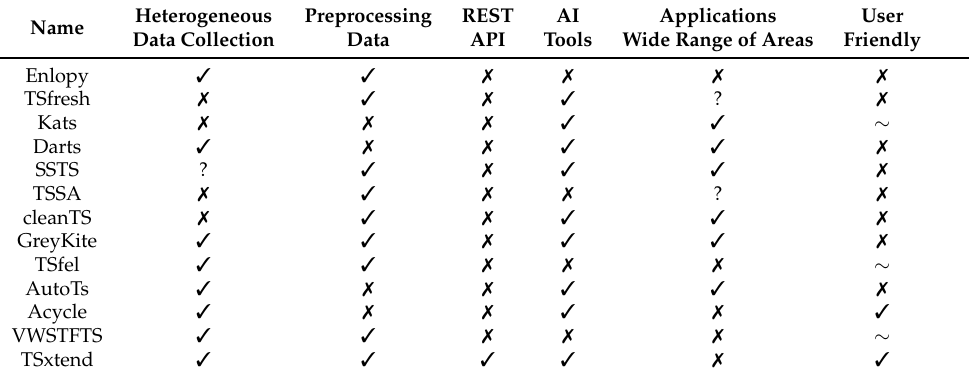
Table 1. Comparison of the proposed tool with the tools mentioned earlier for analysing tempo- ral sensor data. Legend: (cid:51) —Feature supported, (cid:55) —Feature not supported, ∼ —Feature not fully supported or with explicit limitations, ?—Unknown; information not available about the